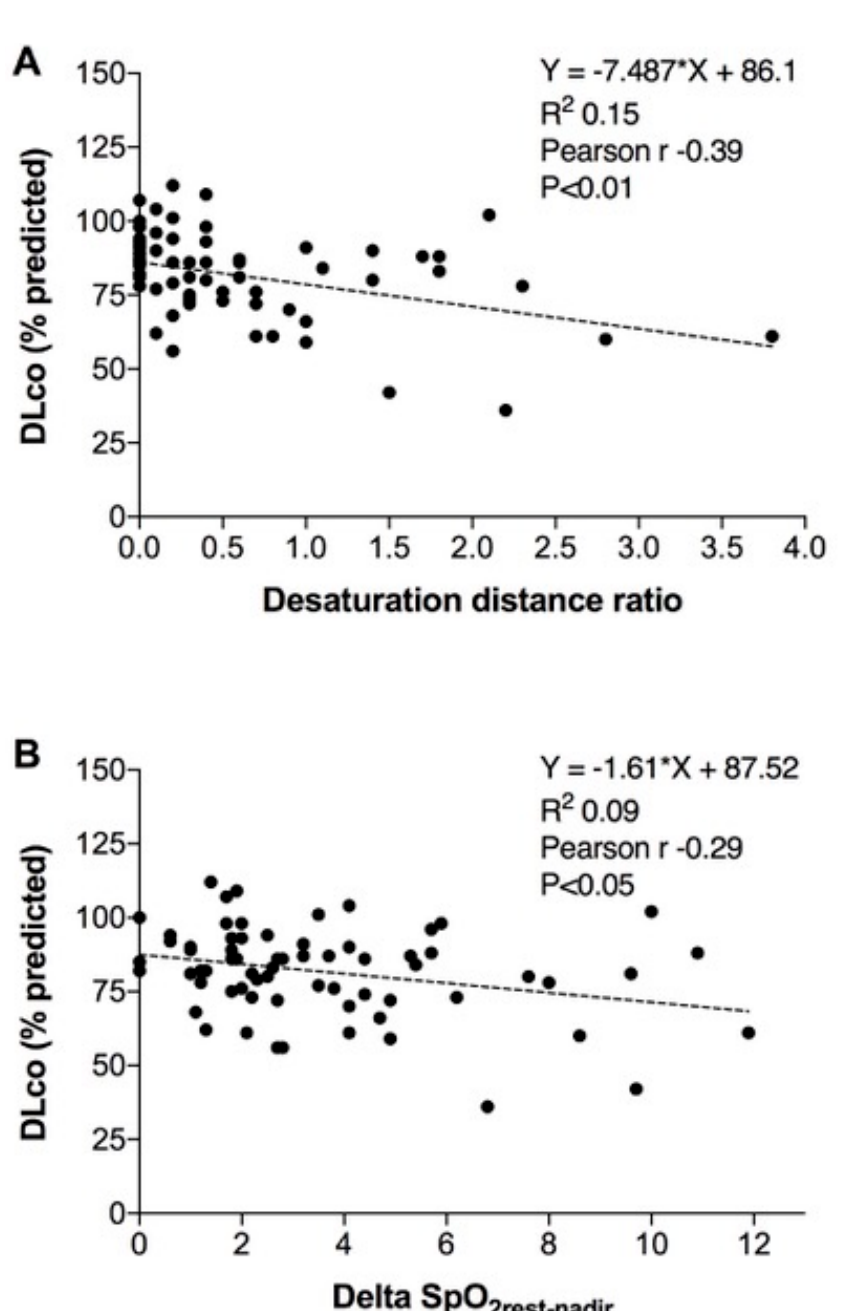
Figure 1. Peripheral saturation at rest (basal), at nadir and the average during the 6-min walk test. Despite the severity, all groups showed a significant desaturation during the test (SpO 2rest-nadir **, p <